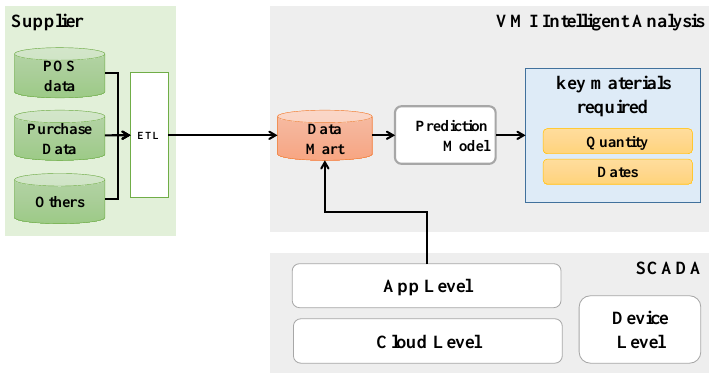
Figure 1. The architecture based on the SCADA of Internet of Things framework.